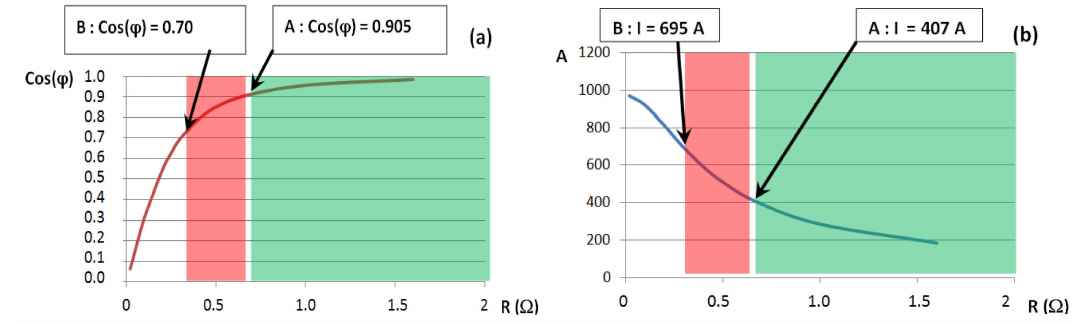
Figure 34. With the same working conditions as used in Figure 32, the power factor seen by the perfect voltage source is plotted ( a ), as well as the current in lines ( b